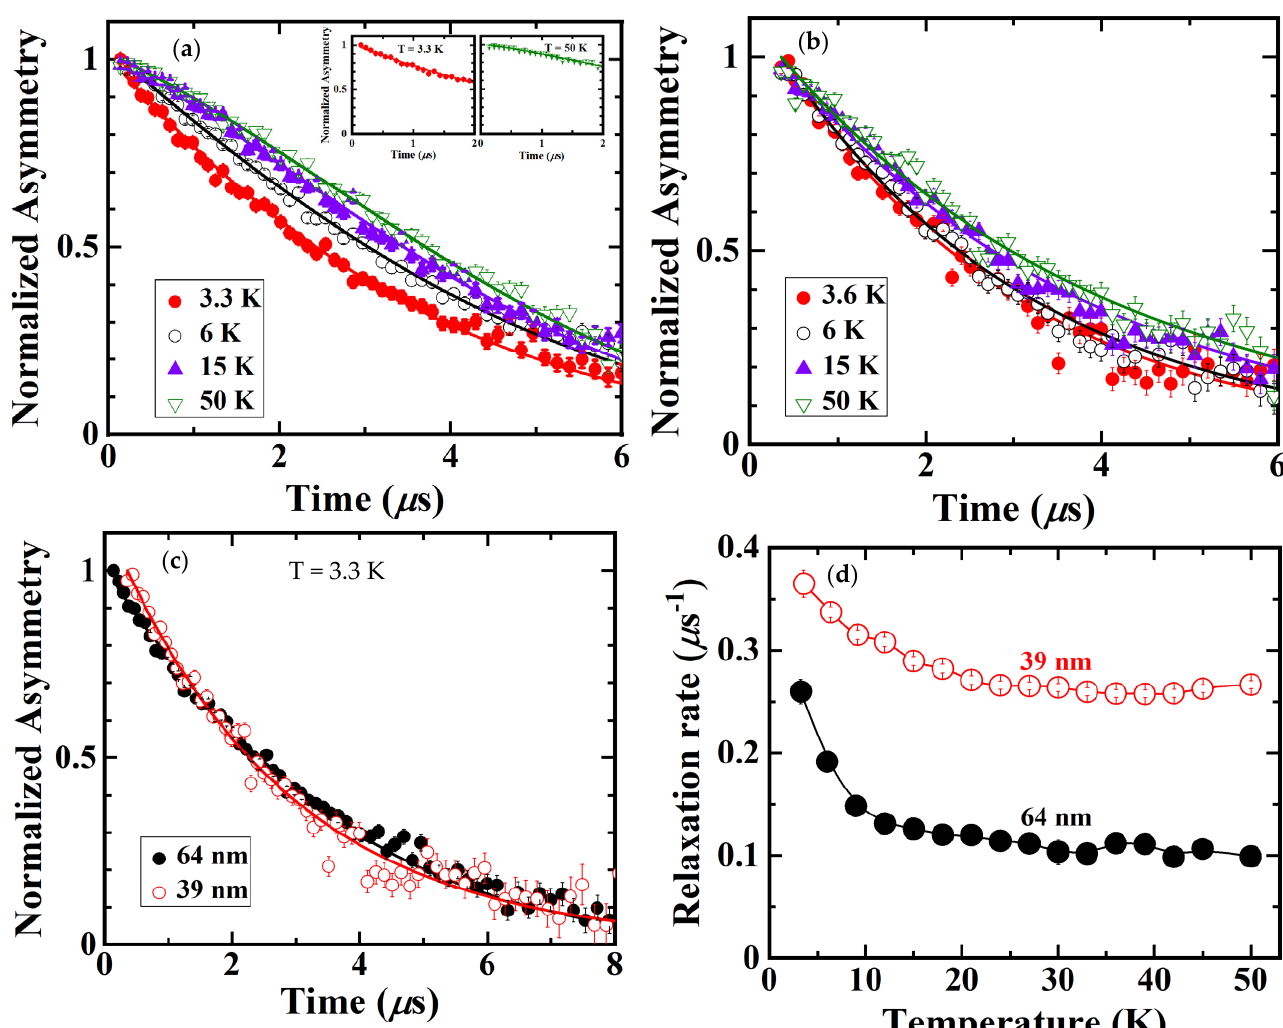
Figure 3. ( a ) Zero-field μ SR time spectra of La 2 − x Sr x CuO 4 nanoparticles with x = 0.20 with the particle size of 64 nm, ( b ) zero-field μ SR time spectra of La 2 − x Sr x CuO 4 nanoparticles with x = 0.20 with the particle size of 39 nm, ( c ) time dependence of normalized asymmetry for both sample at lowest measurement temperature around 3 K, ( d ) temperature dependence of muon-spin relaxation rate of La 2 − x Sr x CuO 4 nanoparticles with x = 0.20.